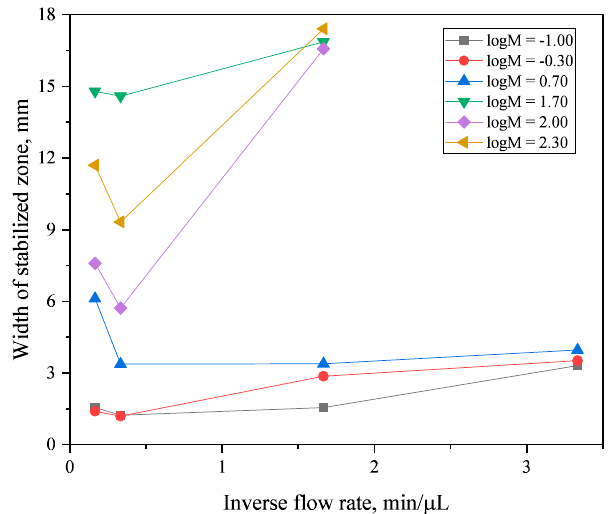
Figure 6. Relation between the width of the stabilized zone of the interfaces and the inverse flow rates in drainage displacement.